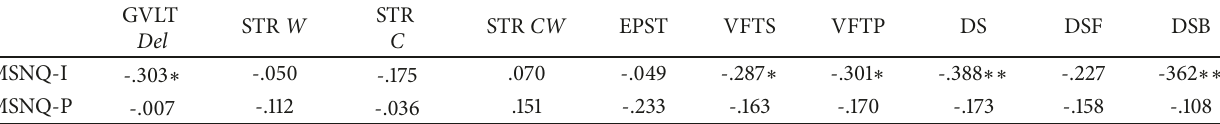
Table 3: Correlation coefficients between the MSNQ and neuropsychological test performance.